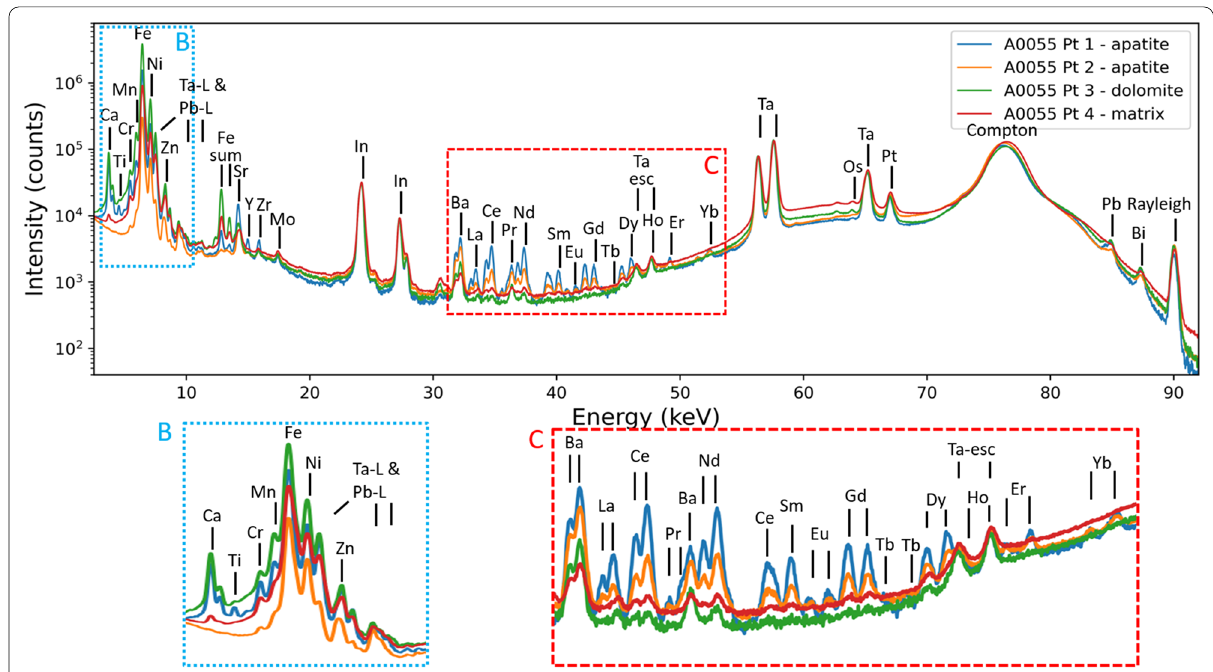
Fig. 3 XRF spectra corresponding to the measurements in points 1 to 4 in rock fragment A0055, as indicated in Fig. 2A (600 s/pt). A clear enhancement in the REE region is observed for points 1 and 2. XRF spectra were normalised for the Ta–K α signal intensity to provide more straightforward comparison. Magnified inserts of two select energy ranges marked by dashed bounding boxes in light blue and red are displayed in parts B and C,